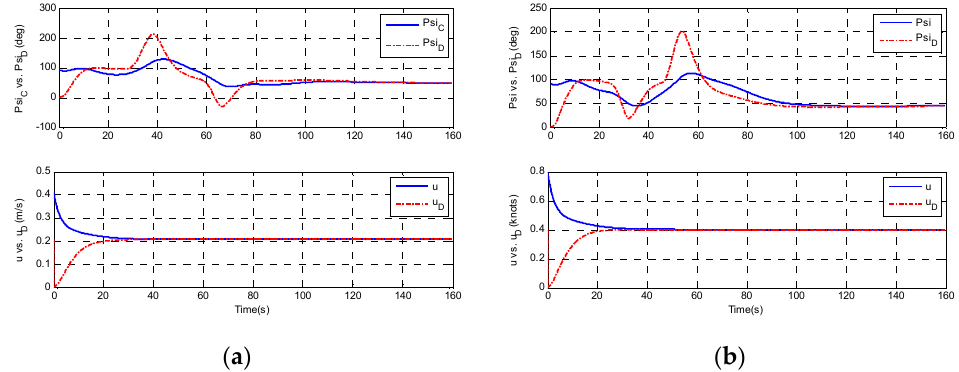
Figure 14. Heading angle, surge speed (desired versus true): ( a ) multi round obstacle; and ( b ) multi rectangular obstacle.